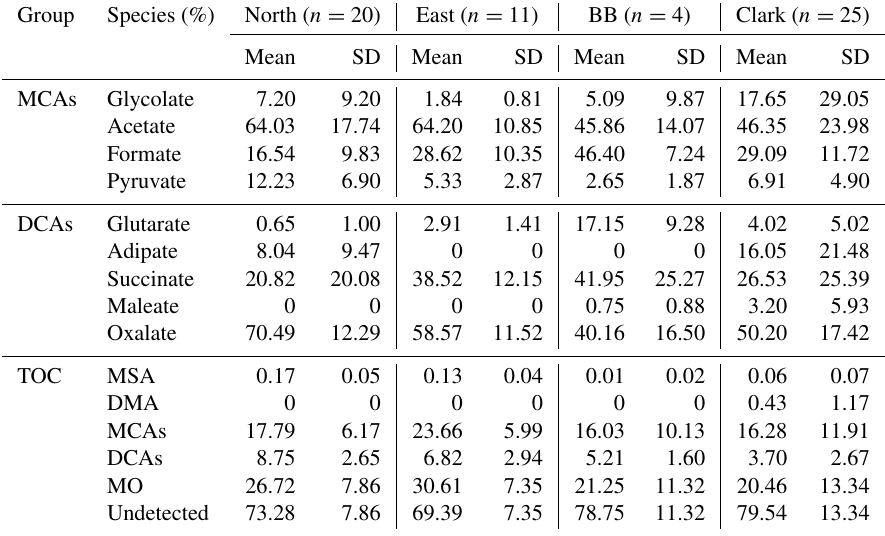
Table 3. Average organic composition for each case study where the first, second, and third groups of rows show the percentage contributions (%) of individual components to monocarboxylic acids (MCAs), dicarboxylic acids (DCAs), and total organic carbon (TOC), respectively.